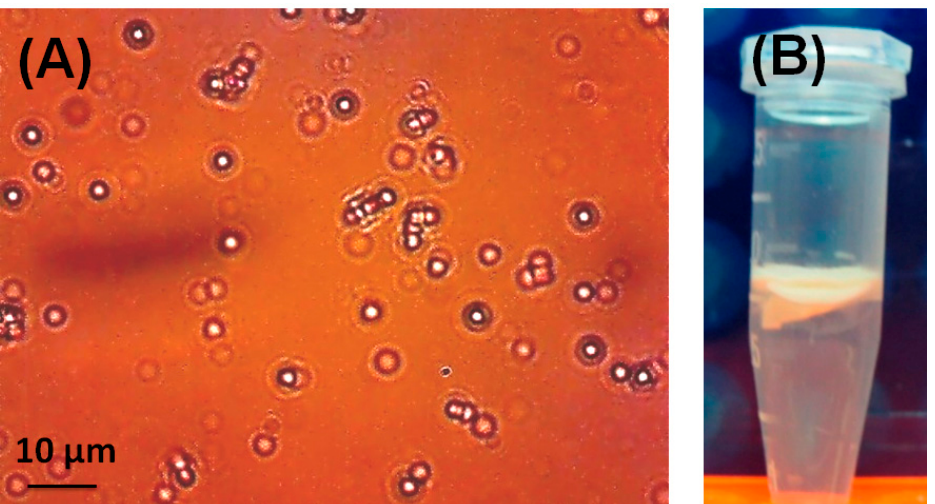
Figure 2. Light microscopy of artificial oil bodies (AOBs) constituted with the recombinant Cal-K conjugated with LSB ( A ). The photo was taken under 800-fold magnification. Bar represents 10 μ m. The floated AOBs were packed as a milky layer on top of the solution in an Eppendorf tube after 10,000 × g centrifugation ( B ).